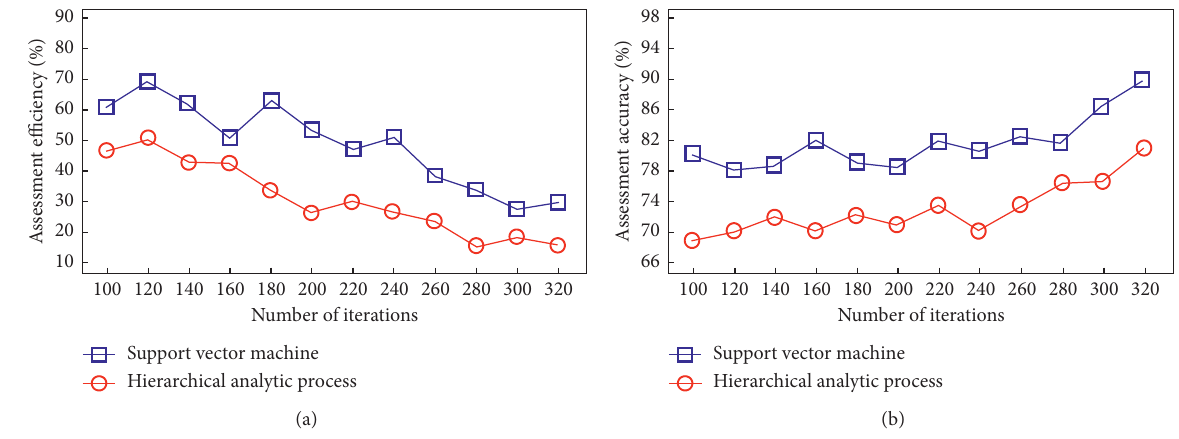
Figure 6: Risk assessment efficiency (a) and accuracy (b) of college student